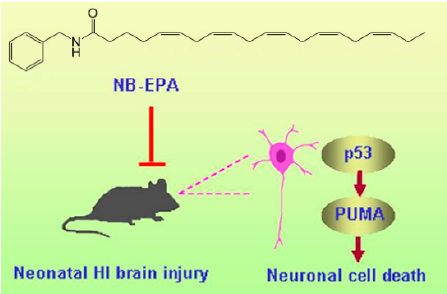
Figure 7. p53, a key regulator of cellular stress response, can be activated in the ischemic areas after brain injury, which then triggers downstream proapoptotic PUMA signaling, thereby resulting in neuronal cell apoptosis, cerebral infarction, and neurobehavioral defects. In contrast, these effects were ameliorated by NB-EPA-mediated suppression of the p53–PUMA pathway.